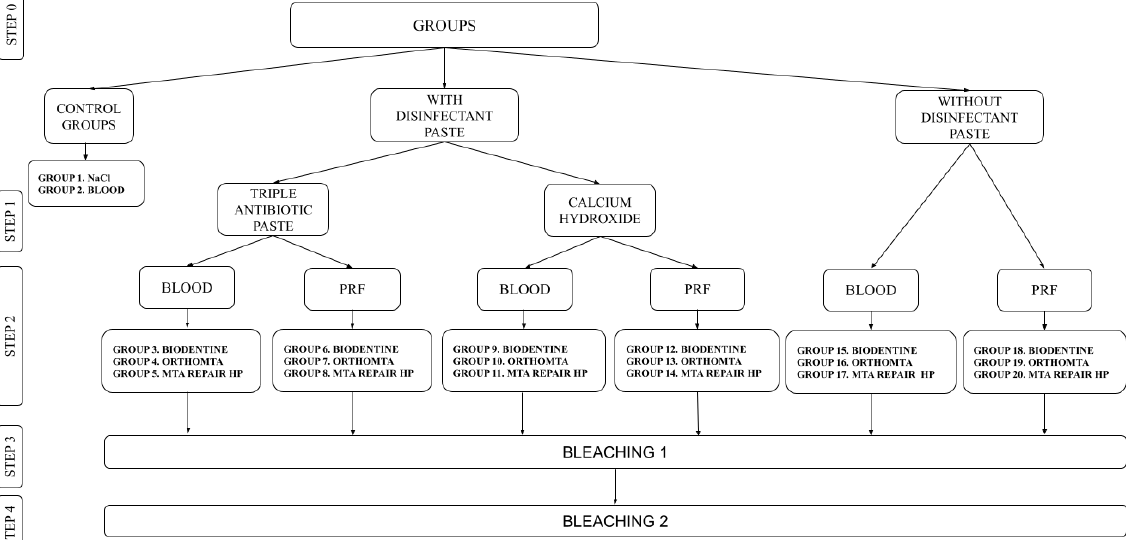
Figure 2. Description of the experimental groups. Abbreviations: PRF, platelet-rich fibrin.